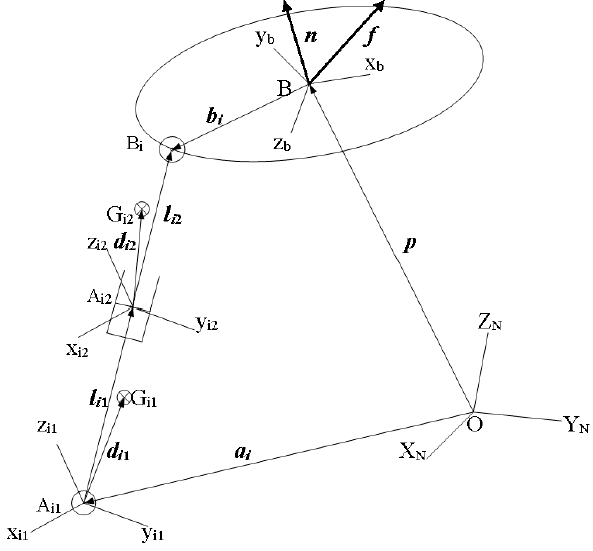
Figure 2. Coordinate systems of link and moving platform.